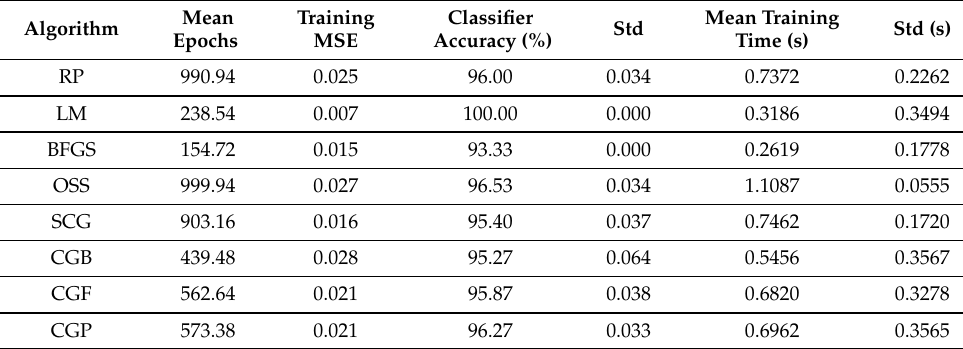
Table 1. A 4-4-3 MLP trained with eight algorithms: performance obtained by averaging 50 random runs. RP—Rprop, SCG—scaled CG, CGB—CG with Powell–Beale restarts,